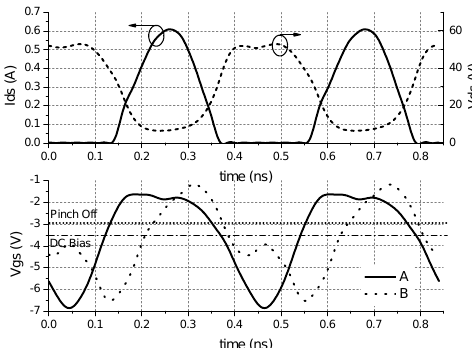
Figure 8. Input (extrinsic) and output (intrinsic) impedance for class-C-F PA.